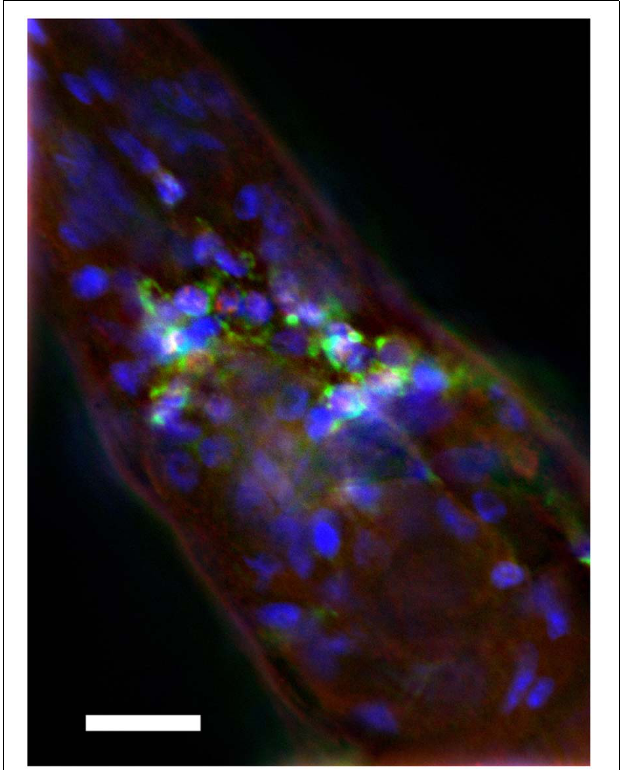
FIGURE 1 | Intraneuronal deposition of A β in transgenic C. elegans . Anterior region of transgenic C. elegans is shown. The strain was immune-stained by anti-A β monoclonal antibody 4G8 (green), anti-TOR-2 polyclonal sera (red), and DAPI (blue). Note cytoplasmic accumulation of A β in nerve ring neurons. Size bar = 10 μ